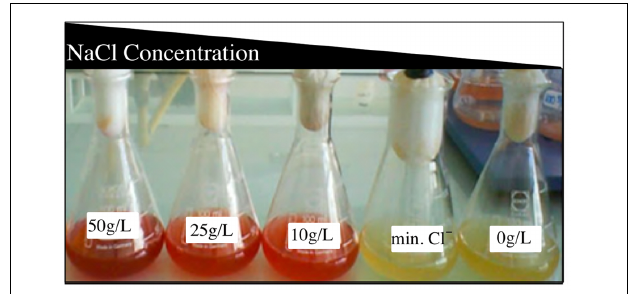
FIGURE 3 | Effect of salinity on the pigmentation of Vibrio sp. Cells were previously adapted to grow in presence of different salt concentration and temperatures, showing non-accumulation of pigment in absence of NaCl.